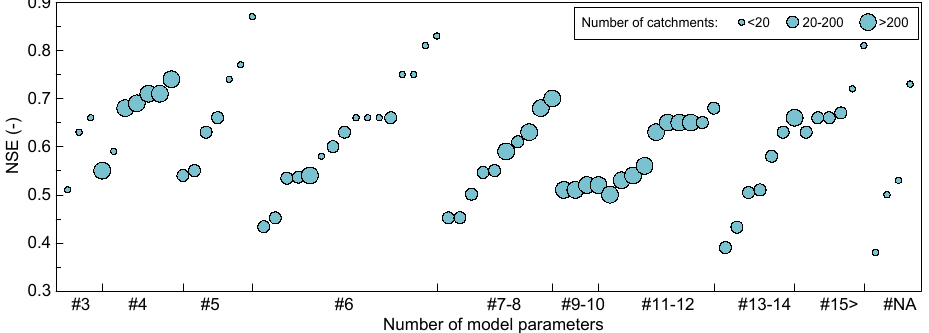
Fig. 6. Median Nash–Sutcliffe efficiency of predicting hydrographs in ungauged basins stratified by model complexity (number of transferred model parameters) and ranked by performance (Level 1 assessment). Each symbol refers to a result from the studies in Table 1. Circle size indicates number of catchments per